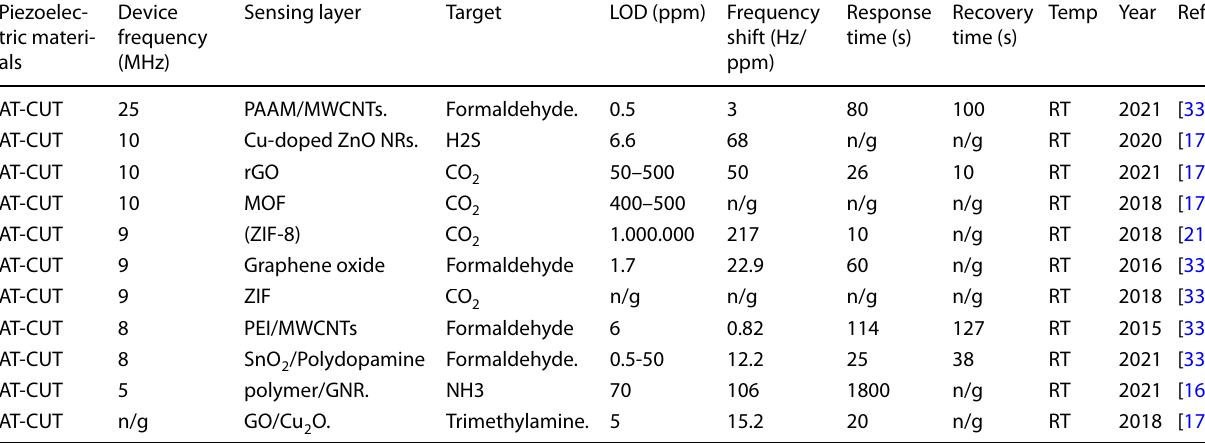
Table 3 Summary for QCM gas